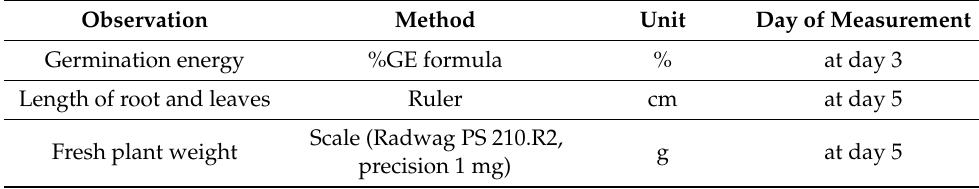
Table 1. Plant seedlings measurements.